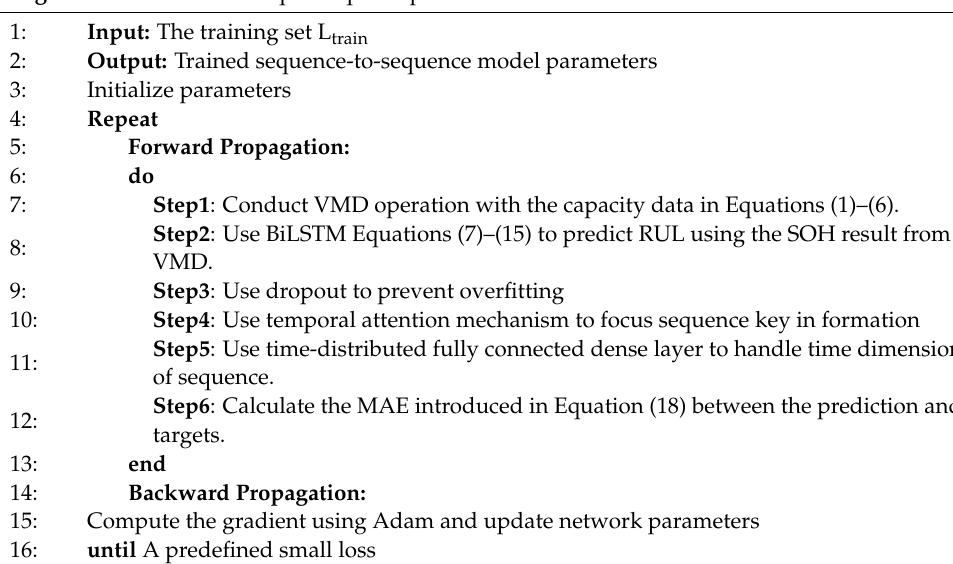
Figure 2. RUL prediction network structure based on the seq-to-seq model. Algorithm 1. Outline of seq-to-seq RUL prediction model for lithium